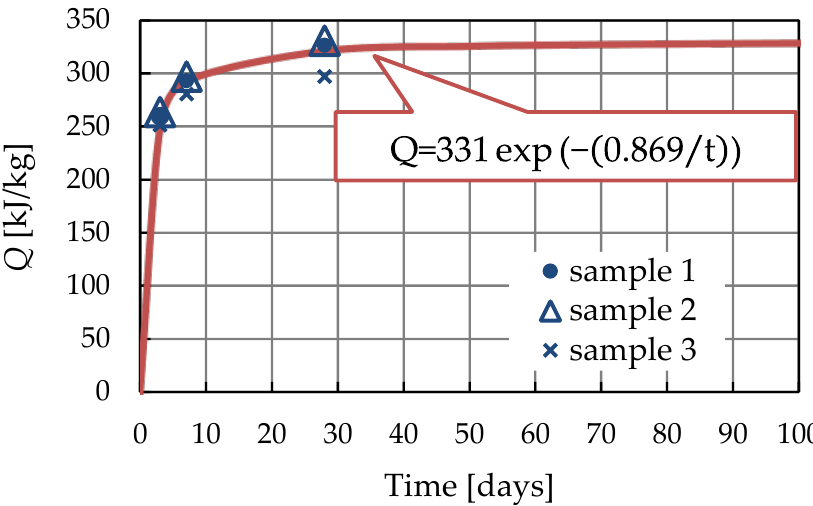
Figure 7. Cement heat of hydration development.